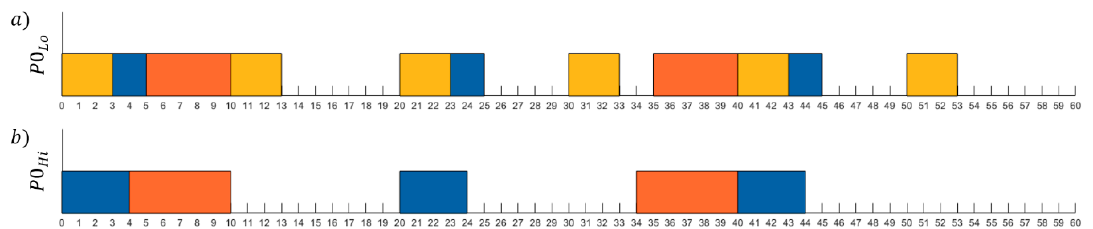
Figure 2. Scheduling the three-task set example in ( a ) Lo-criticality mode and ( b ) Hi-criticality mode.